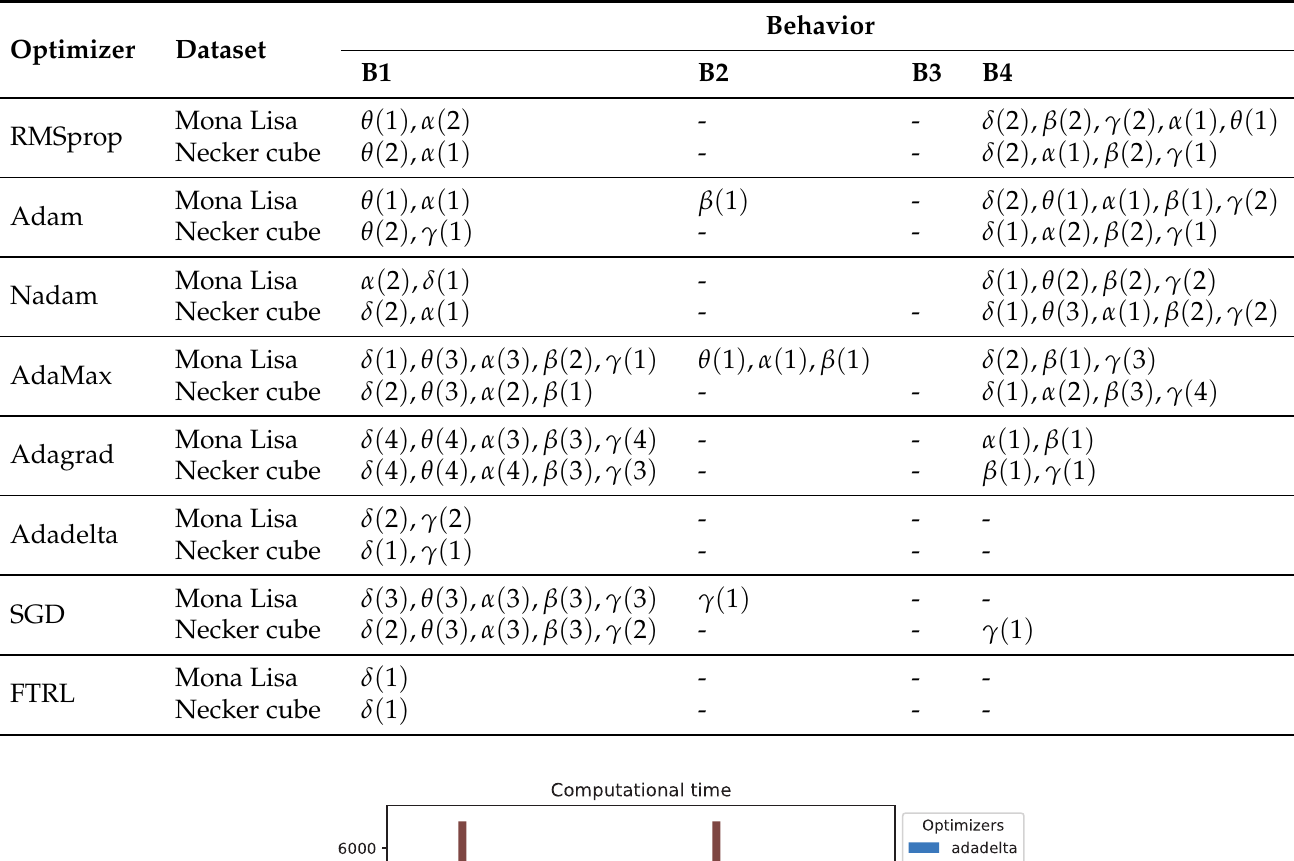
Table 16. Comparability within two datasets based on behavior and optimizer. Here, the cell value is the frequency bands whose f1-score is more than 70% and the number of the frequency corresponds to the behavior in brackets. B1/B2/B3/B4 are defined in Table 6.